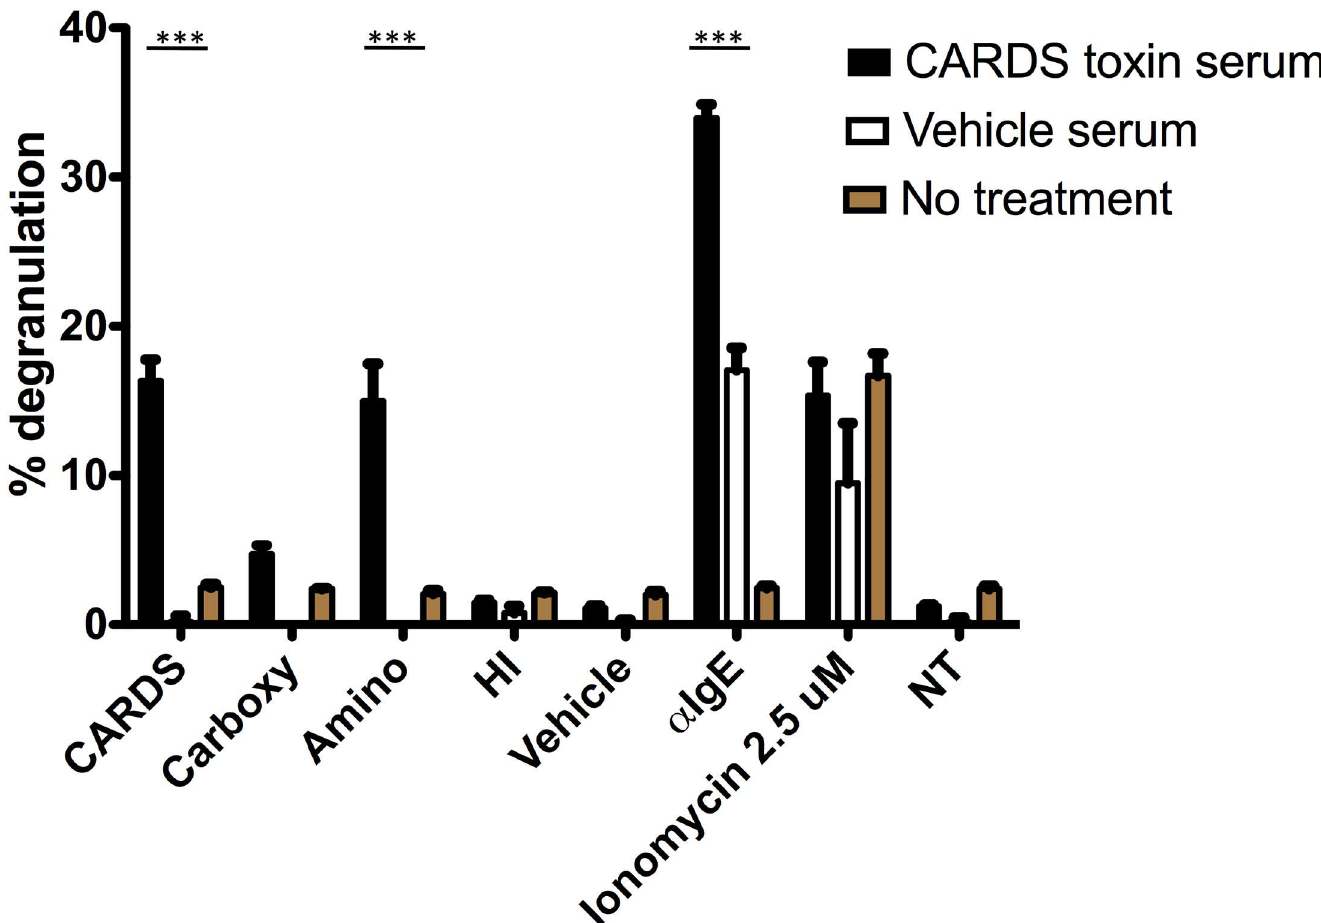
Fig 6. Mast cells sensitized with serum containing anti-CARDS toxin-specific IgE degranulate in response to CARDStoxin challenge. BMMCs were sensitizedwith pooledserum collected from mice 56 days after exposure to CARDS toxin or vehicle. As a negative control, BMMCs were mock sensitized with saline(NT). Sensitizedmast cells were then challenged with equimolaramounts of full-lengthCARDS toxin, C-terminal peptide(amino acid 269–591), N-terminal peptide(amino acid 1–249), HI toxin, vehicle, anti-IgE, ionomycin,and mock challenged(NT). Percent degranulation is extrapolated from hexosaminidase release into the culture supernatant.( *** p < 0.005, data is presented as the mean and standard deviationof two independent experiments done in